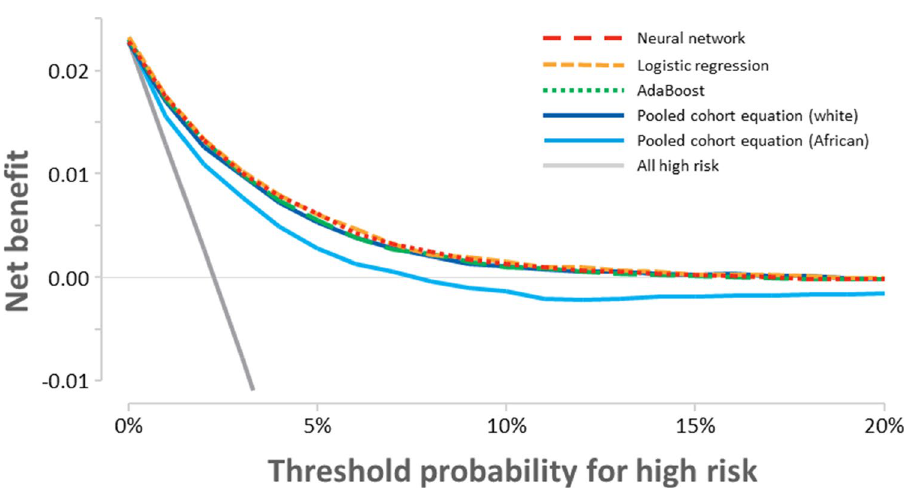
Figure 4. Decision curves for pooled cohort equations and machine learning-based models. Pooled cohort equation (white), pooled cohort equation for whites; pooled cohort equation (African), pooled cohort equation for African